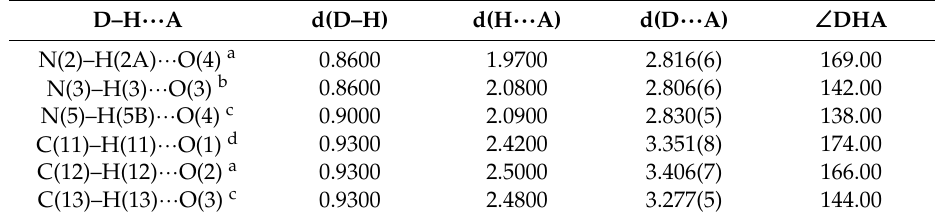
Table 3. Hydrogen bond lengths (Å) and bond angles ( ◦ ) for 1 .